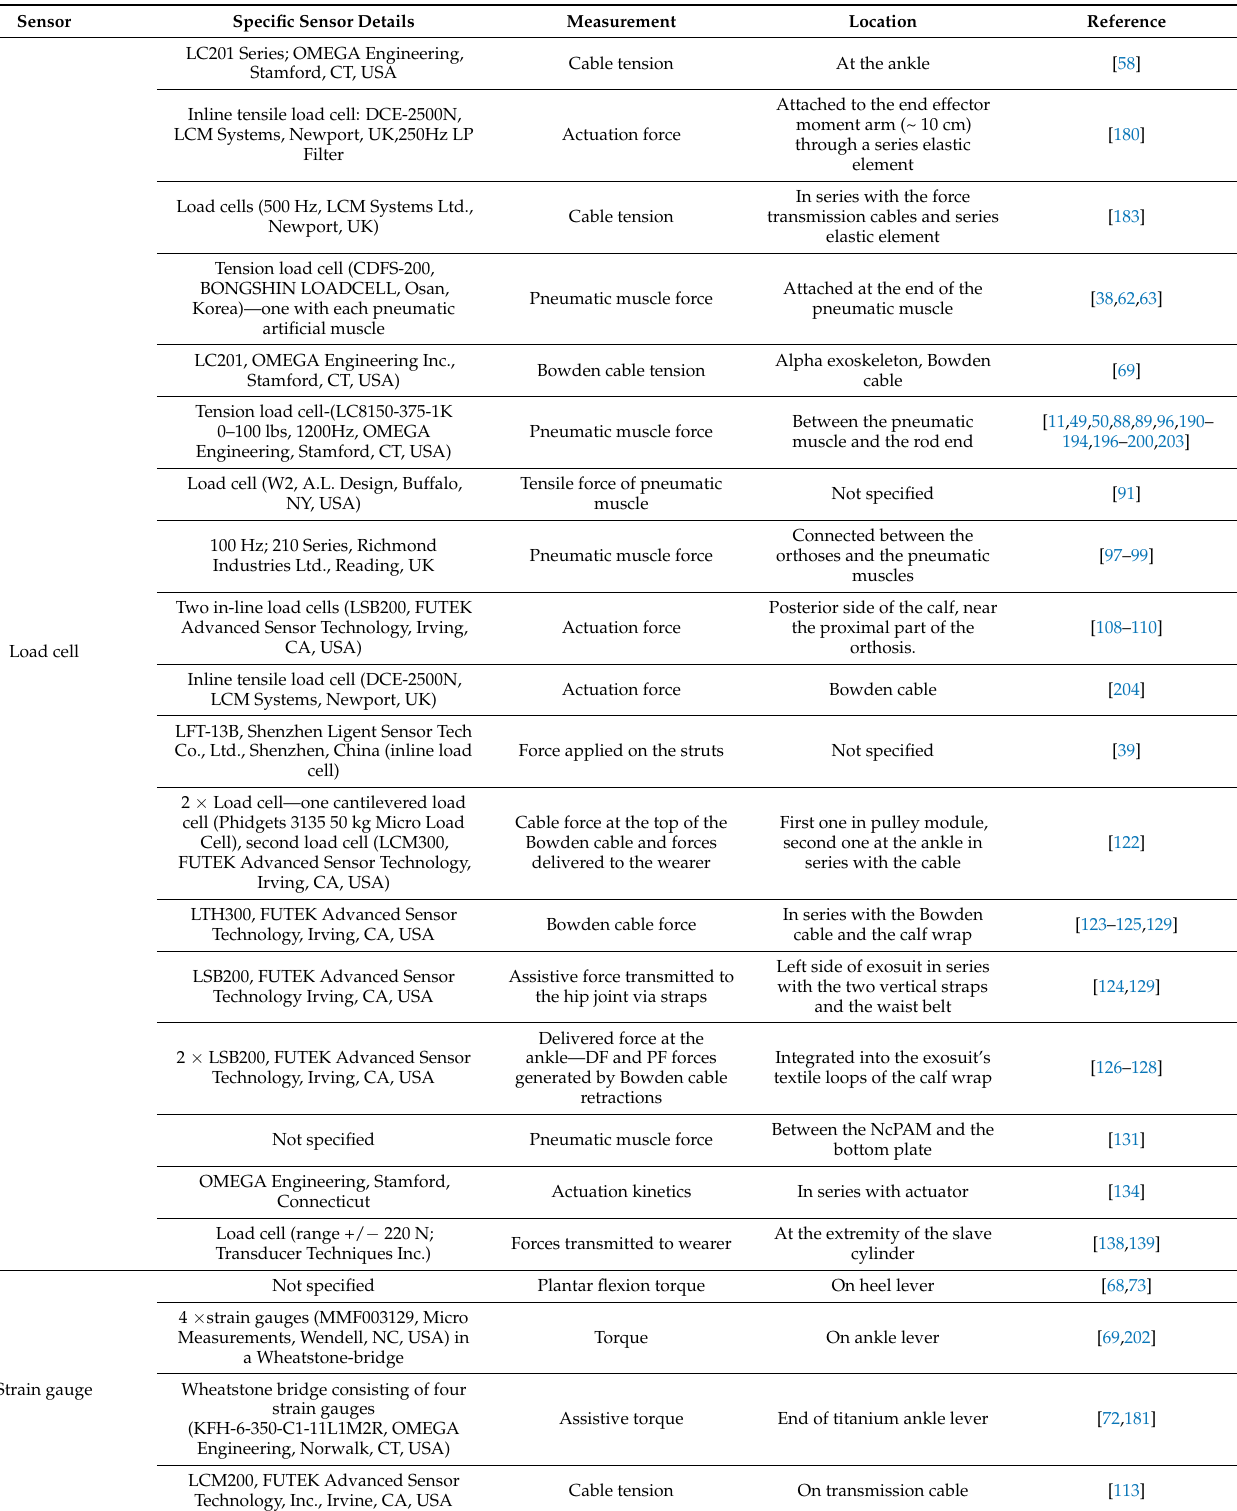
Table 8. Detailed technical information of different machine–machine interface sensors used in the reviewed PAEs, including the specific sensor type, measured parameter, and sensor placement